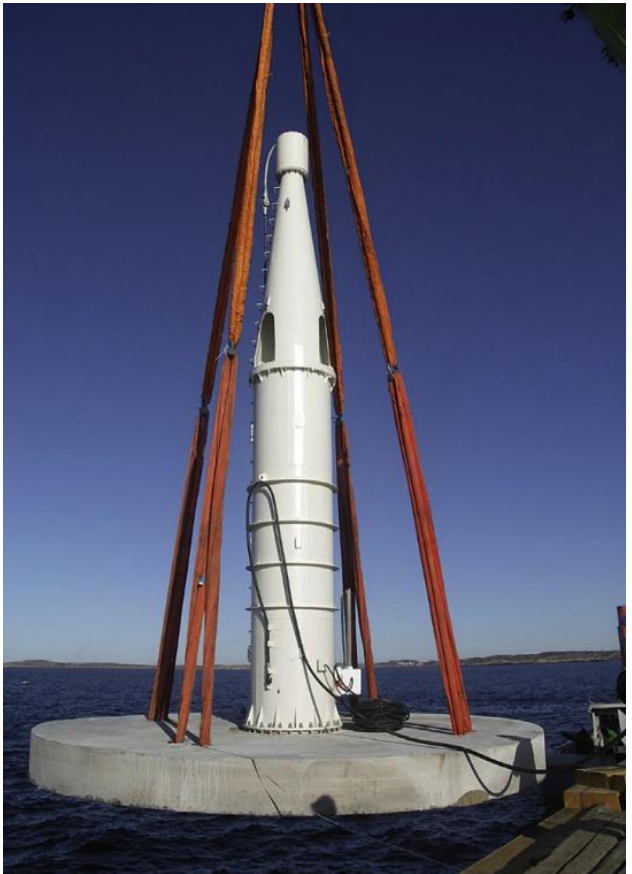
Figure 10. Deployment of the WEC developed by Uppsala university in the sea [6] .